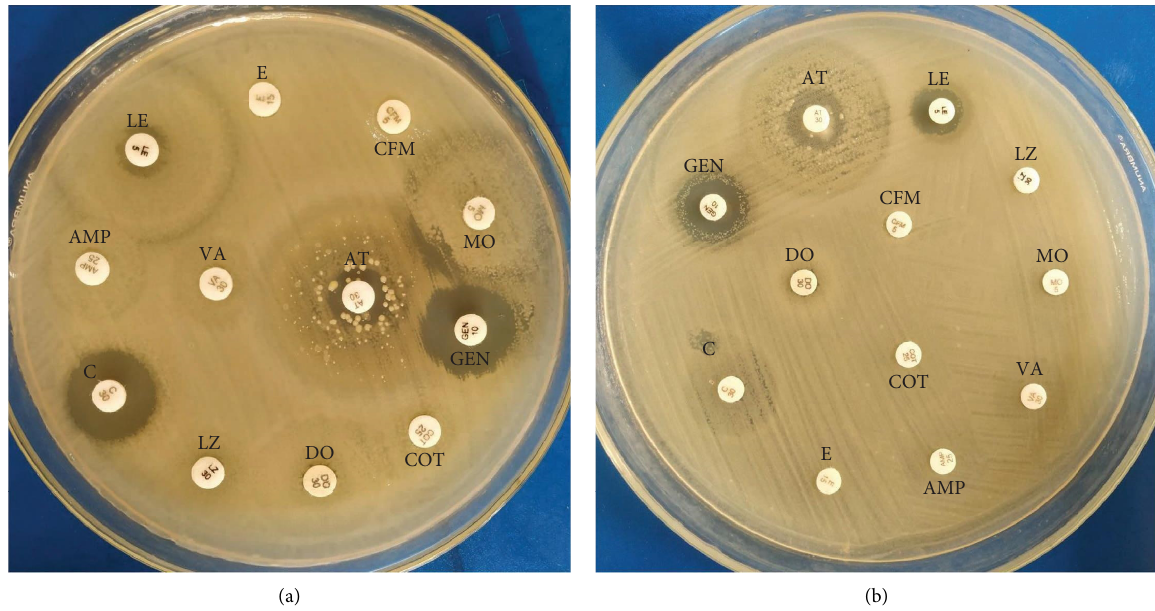
Figure 8: Antibiogram profle using 12 antibiotics (E: erythromycin, CFM: cefxime, OM: moxifoxacin, GEN: gentamycin, COT: trimethoprim, DO: doxycycline, LZ: linezolid, C: chloramphenicol, AMP: ampicillin, LE: levofoxacin, VA: vancomycin, and AT: aztreonam) covering several class against (a) Bacillus spp. and (b) Pseudomonas